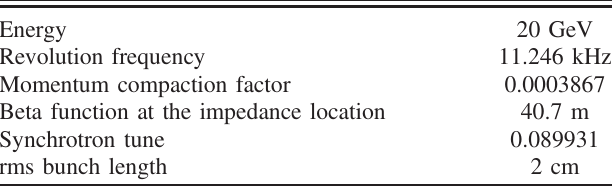
FIG. 20. The flat contour plot of the growth factor g × T function of ϒ and χ at the rms bunch length of 2 cm in the LEP resonator model for the Vlasov analysis with the Gaussian bunch